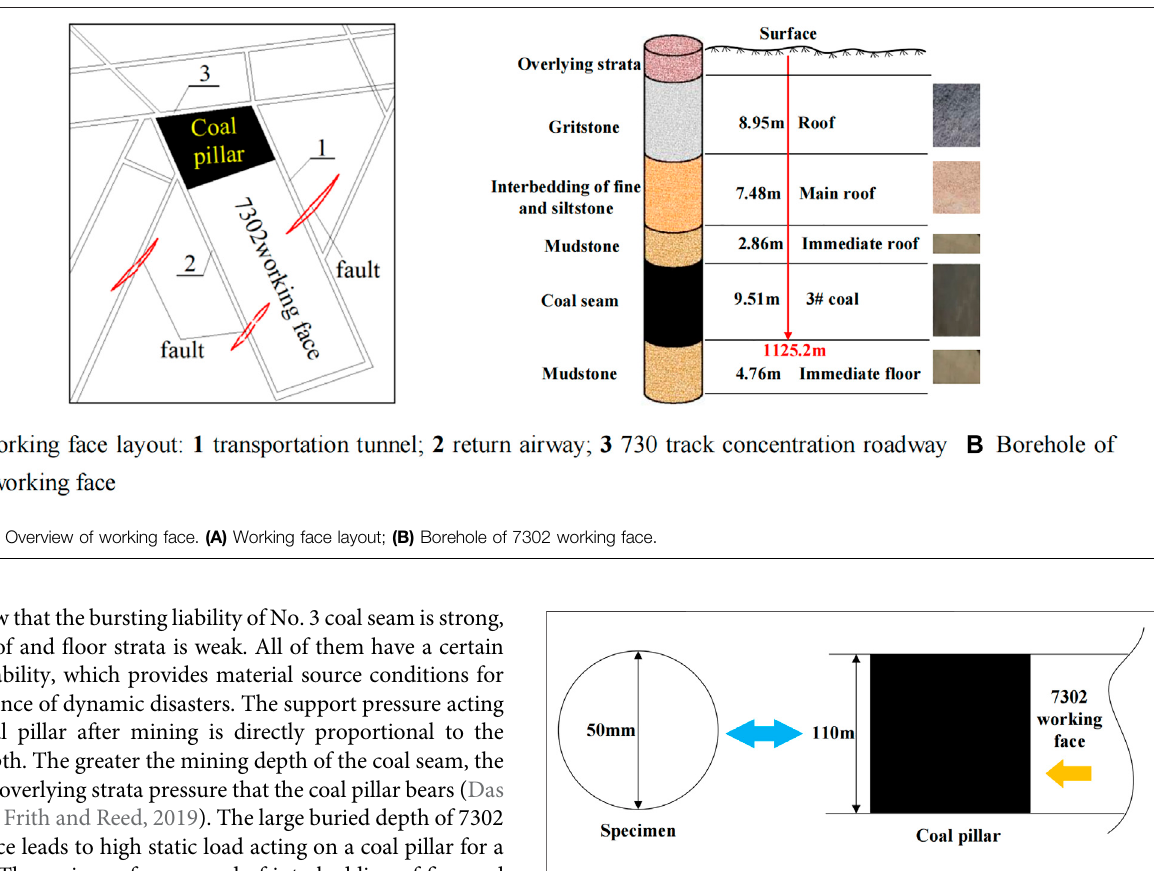
FIGURE 3 | Test similarity